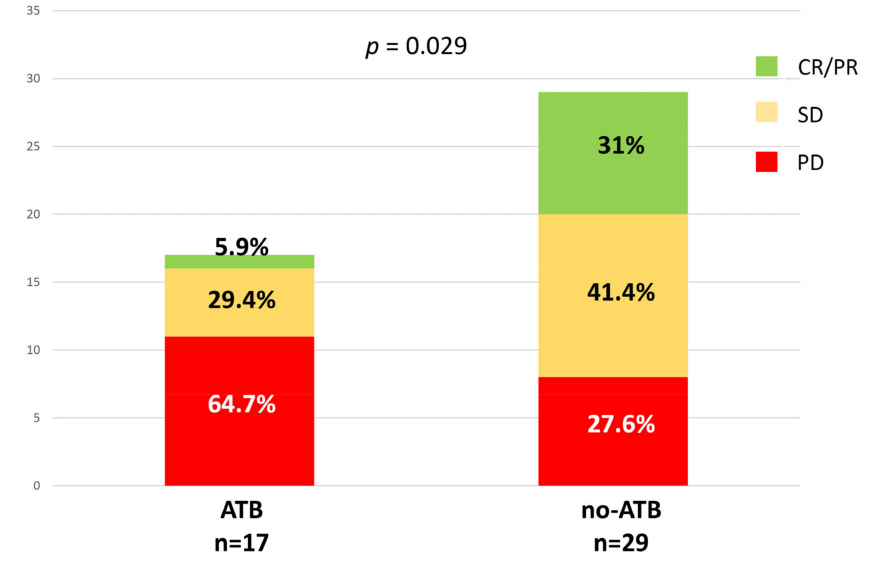
Figure 2. Association between ATB exposure and the radiologic response at the first evaluation according to iRECIST (immunotherapy RECIST)